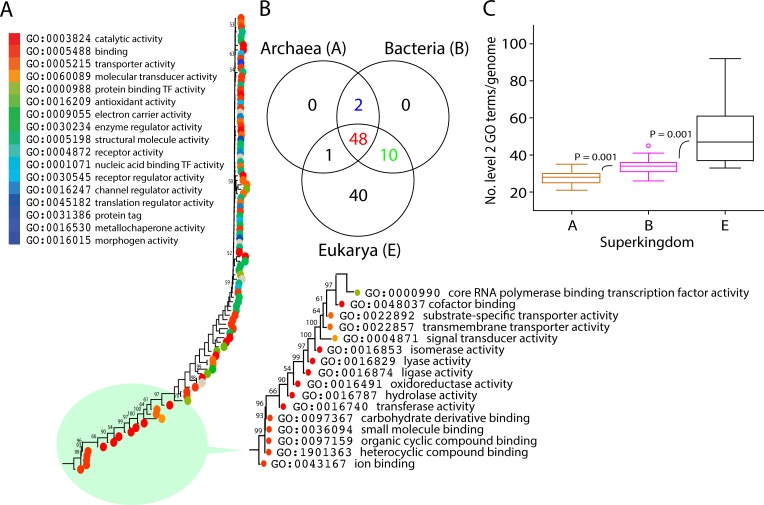
Evolution of level 2 GO terms.(A) A ToF potraying evolution of level 2 GO terms (Tree length = 12,363). Molecular functions are colored according to corresponding level 1 GO terms. Nonparametric BS values are shown above branches, which are supported by more than 50% of 1,000 replications. The tree was rooted by the Lundberg method. Tree length = 12,363, RI = 0.92, CI = 0.46, Hi = 0.53, and g1 = -0.67. (B) Venn diagram illustrates the distribution numbers of level 2 molecular functions in the three superkingdoms. (C) Boxplots shows the number of level 2 GO terms per genome. Comparisons are significant at 0.001. A: Archaea, B: Bacteria, E: Eukarya.